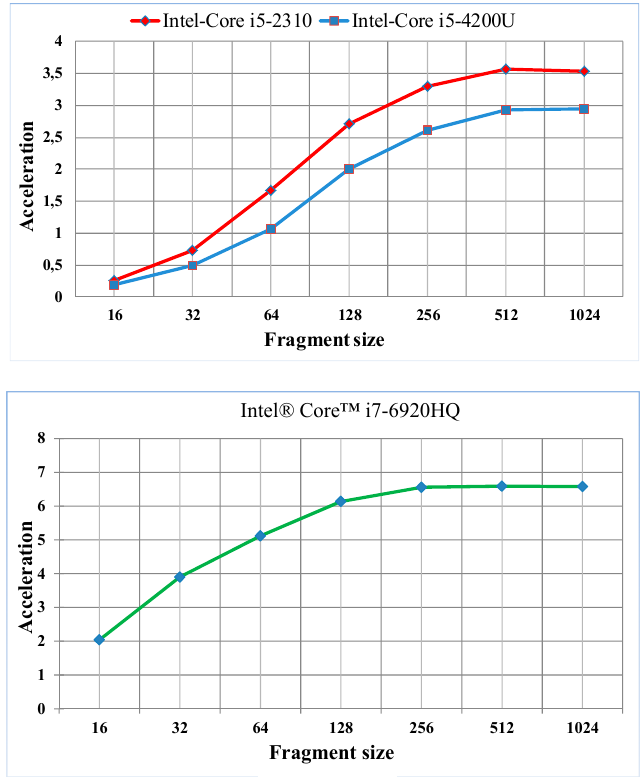
Figure 4. Acceleration results for 2D parallel spectral analysis.